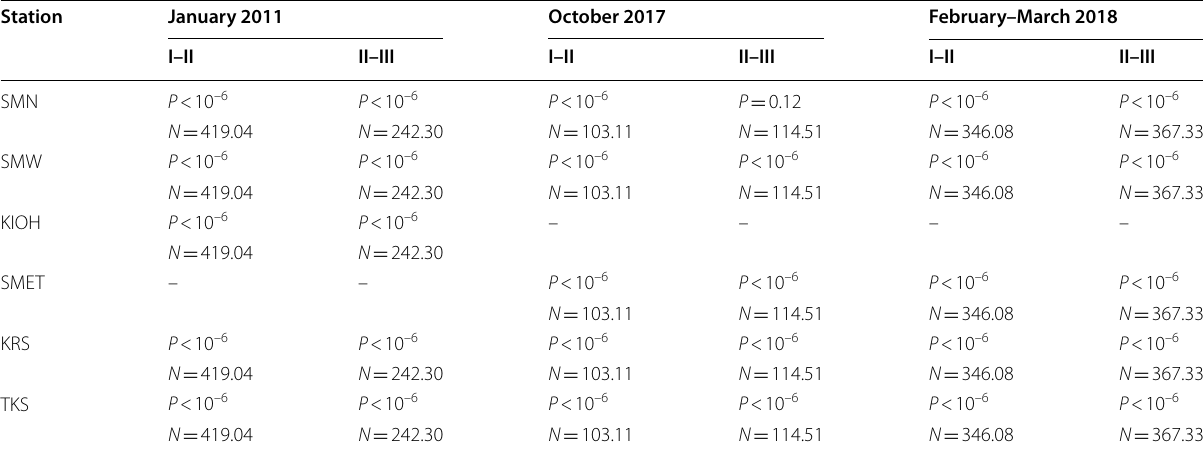
Each pair of periods contains the corresponding p-value and the metric N that should be larger than 4 in order for the test results to be reliable. Empty spaces denoted “–” for stations SMET and KIOH signify lack of data during January 2011 and October 2017, February–March 2018, respectively